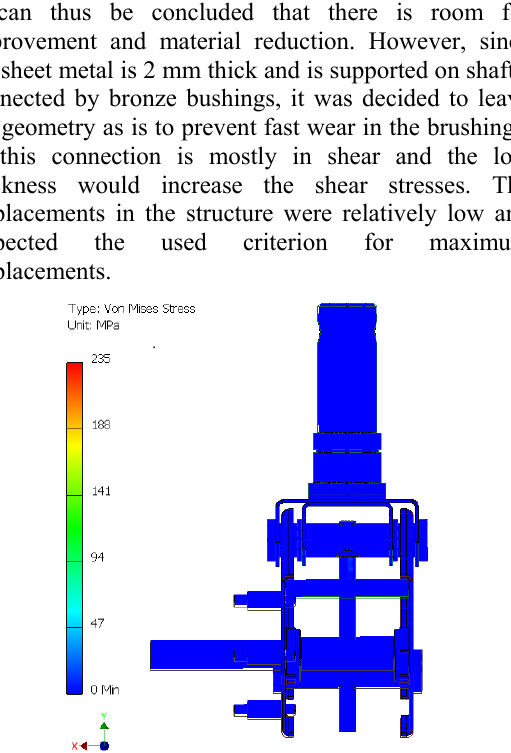
Figure 18. Equivalent stress of von Mises in the drive wheel